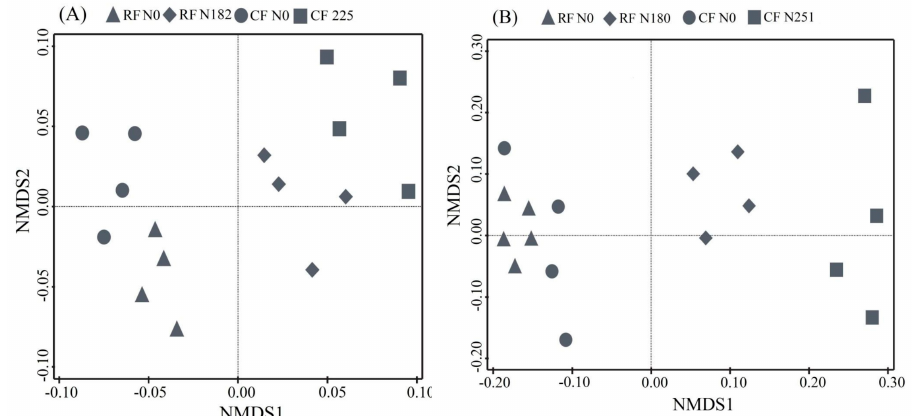
Figure 3. Non-metric multidimensional scaling (NMDS) of bacterial communities under long-term fertilization in fluvo-aquic soil ( A ), and black soil ( B ), based on Bray-Curtis dissimilarities.